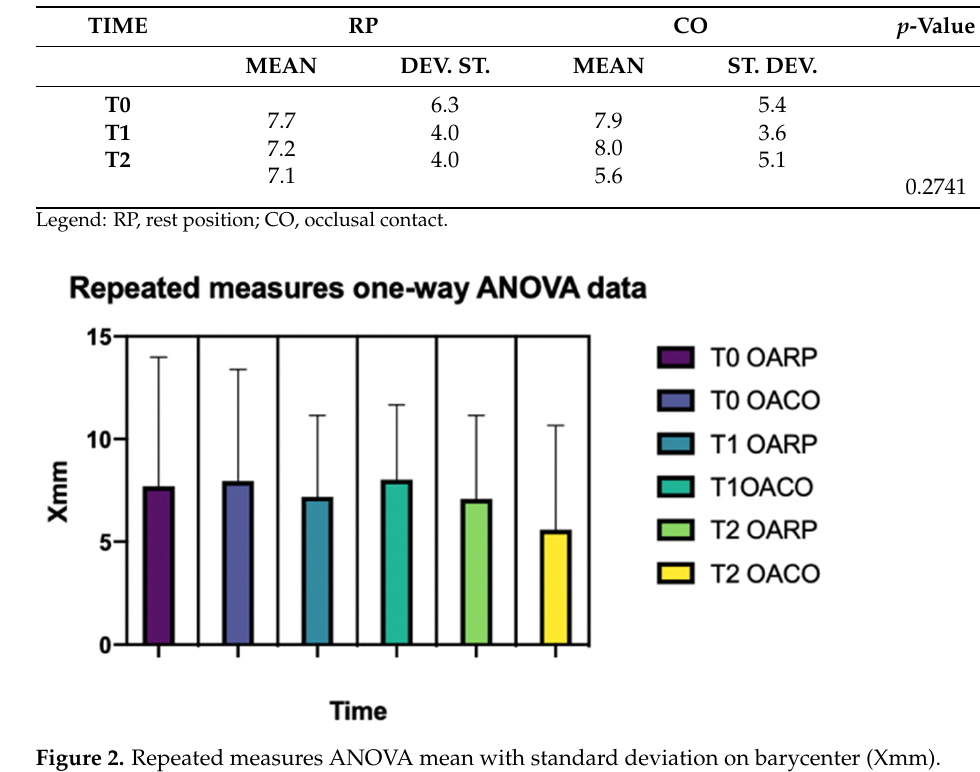
Table 1. Friedman test on barycenter (Xmm).